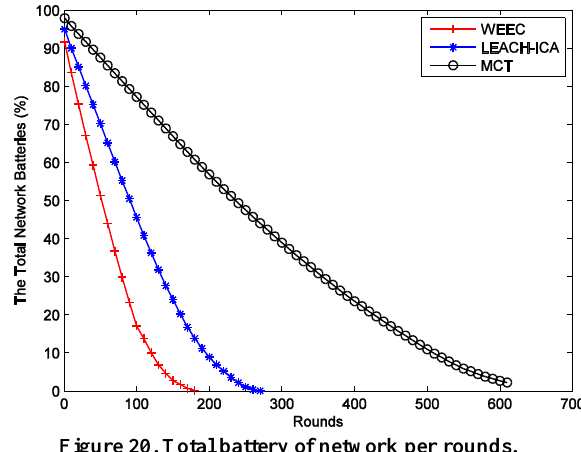
Figure 20. Total battery of network per